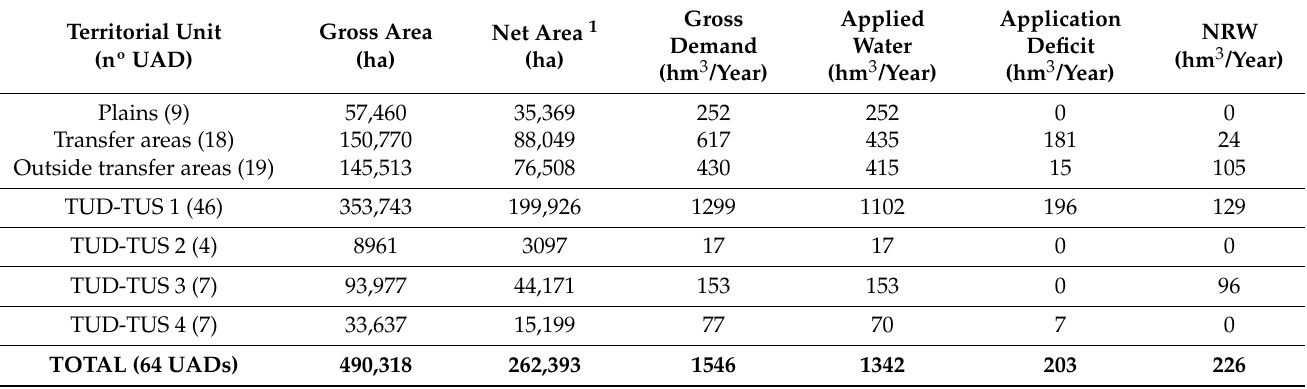
Table 9. Distribution by origin of the water for agricultural demand by TU (horizon 2015). Source: own elaboration based on